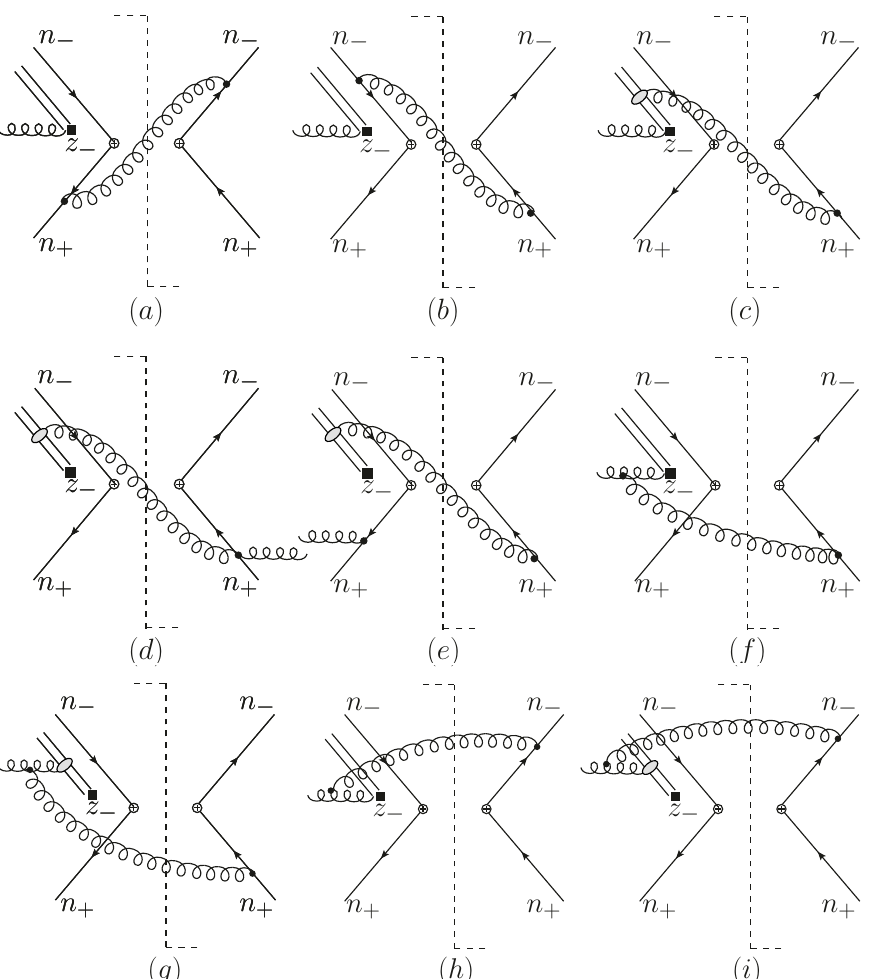
Figure 2 . One-loop diagrams with gluon passing the cut for the one-gluon matrix element of the soft operator S 2 (cid:24)